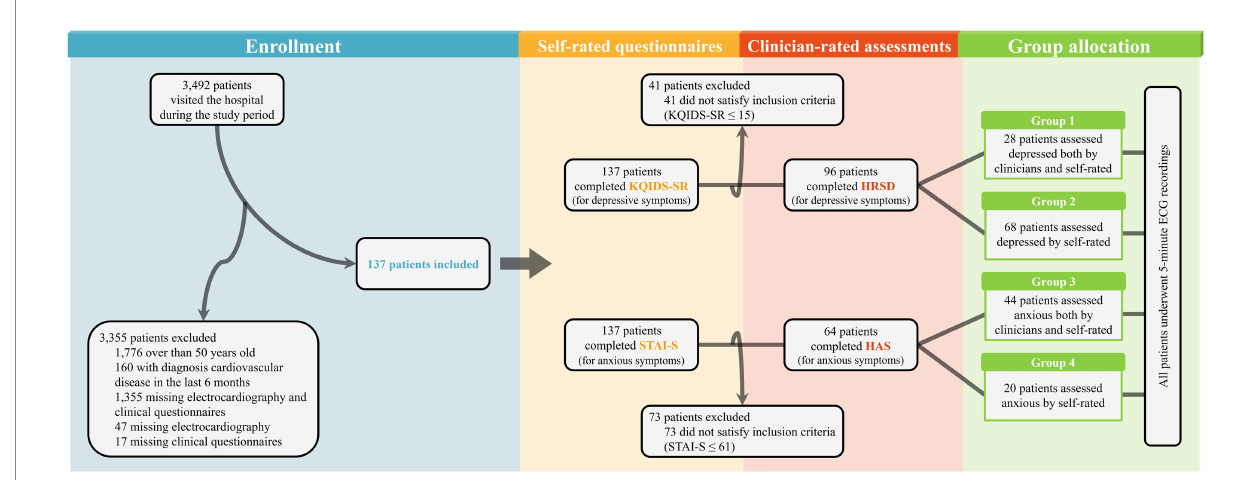
FIGURE 1 Flow diagram of participants’ enrollment, assessment, and allocation. KQIDS-SR, Korean Quick Inventory of Depressive Symptomatology Self-Report; STAI-S, State–Trait Anxiety Inventory-State; HRSD, Hamilton Rating Scale for Depression; HAS, Hamilton Anxiety Scale; ECG,